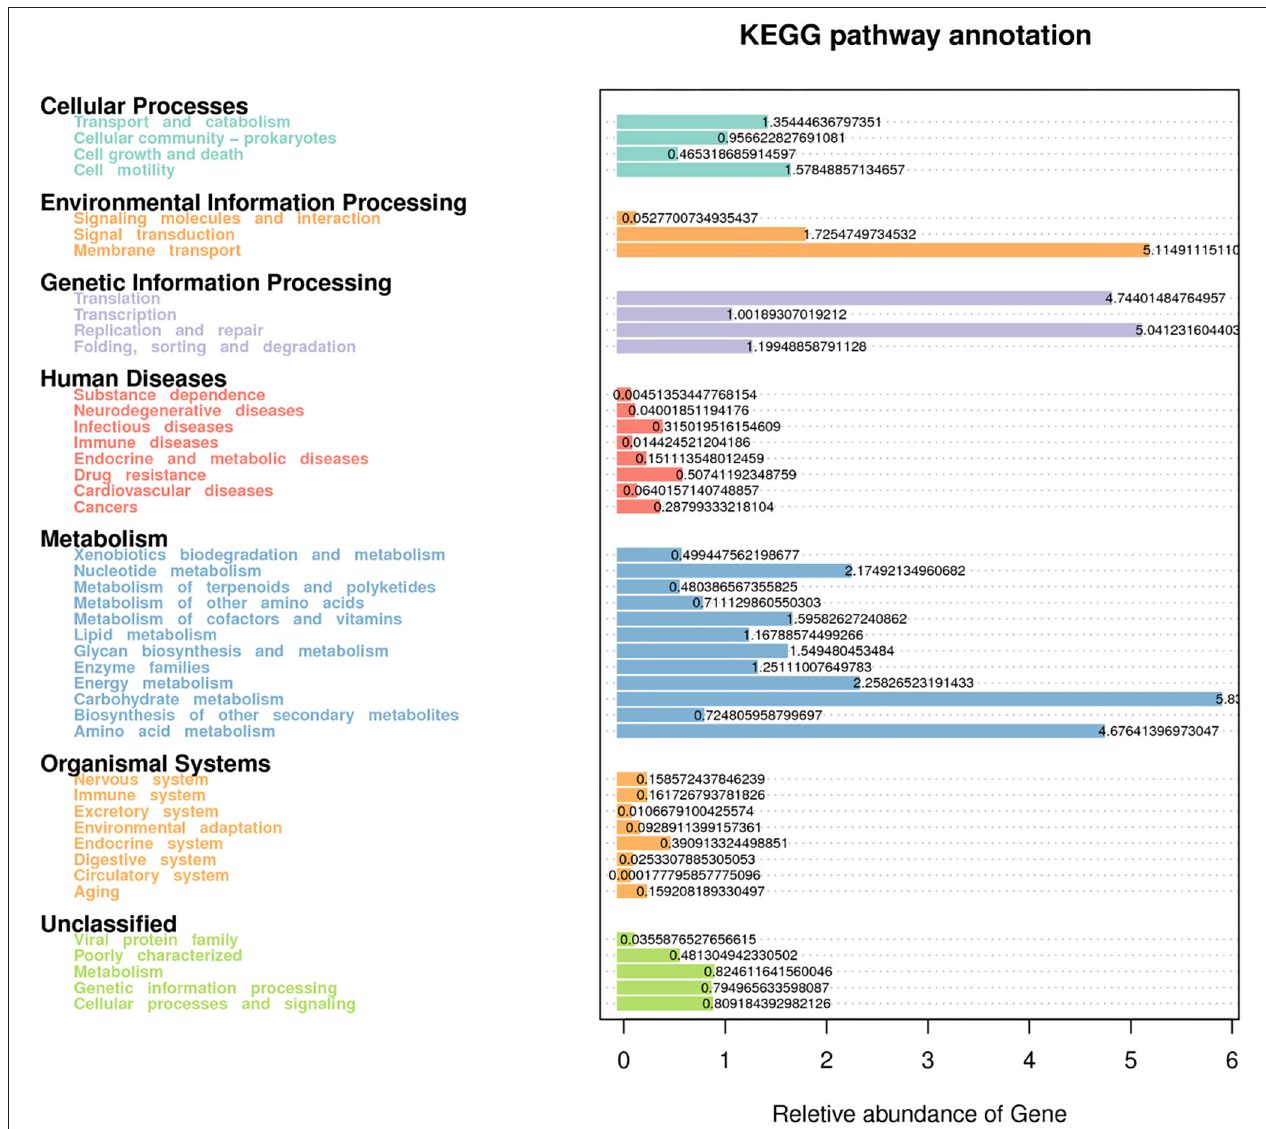
FIGURE 5 | Predictive functional analysis using Tax4Fun tool, showing relative abundance of assigned KEGG identity to the pathways of metabolisms at subsystem levels (KO 2